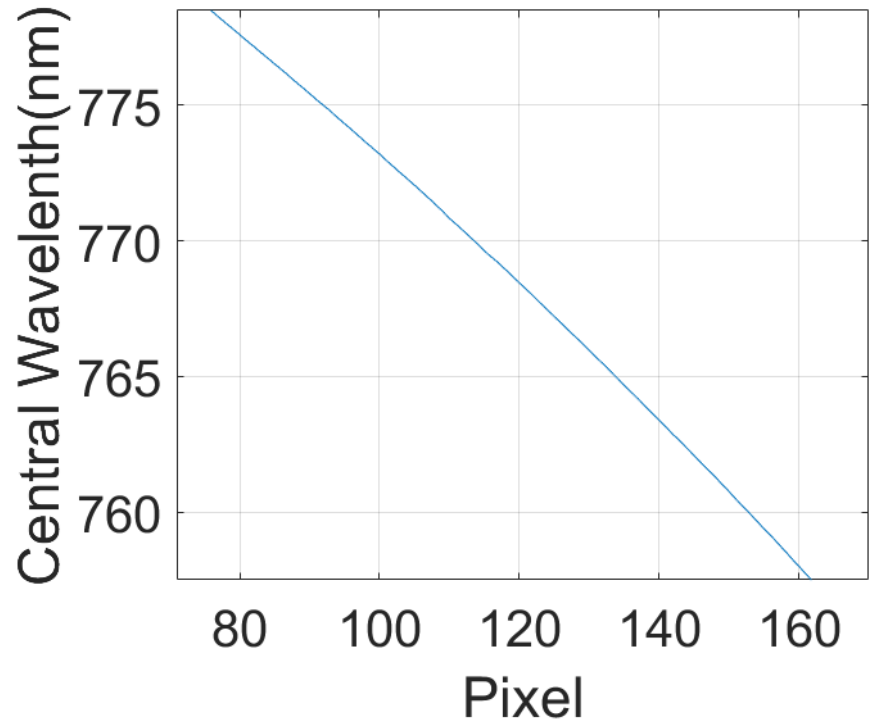
Figure 6. Central wavelengths that relate to the pixels in the 150th column.